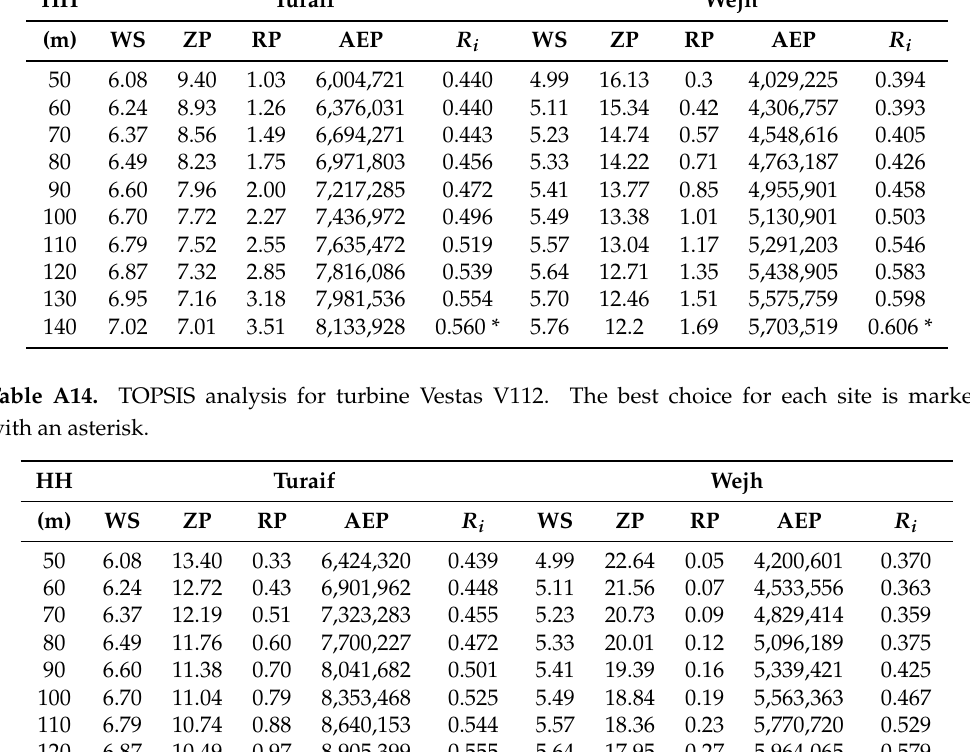
Table A13. TOPSIS analysis for turbine Vestas V110. The best choice for each site is marked with an asterisk.